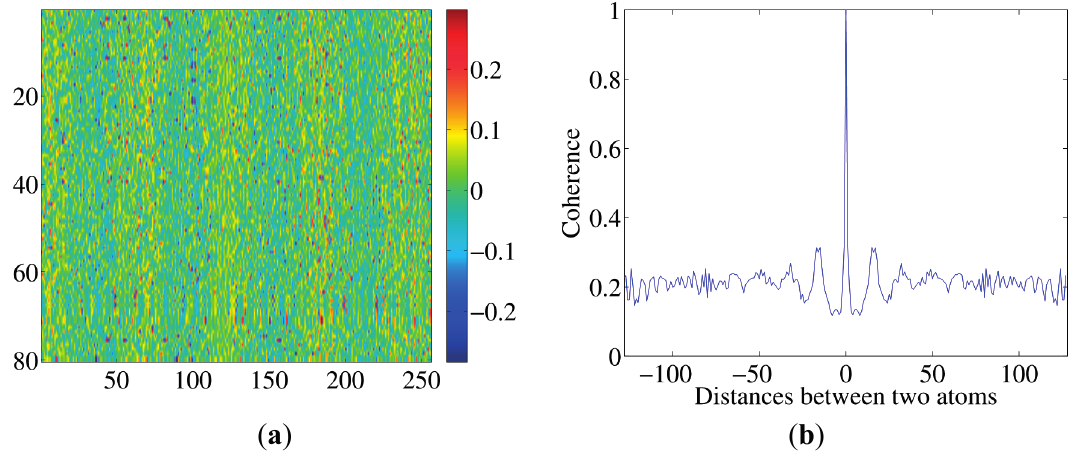
Figure 3. ( a ) A real part of the matrix A example; ( b ) A ’s average correlation coefficients.